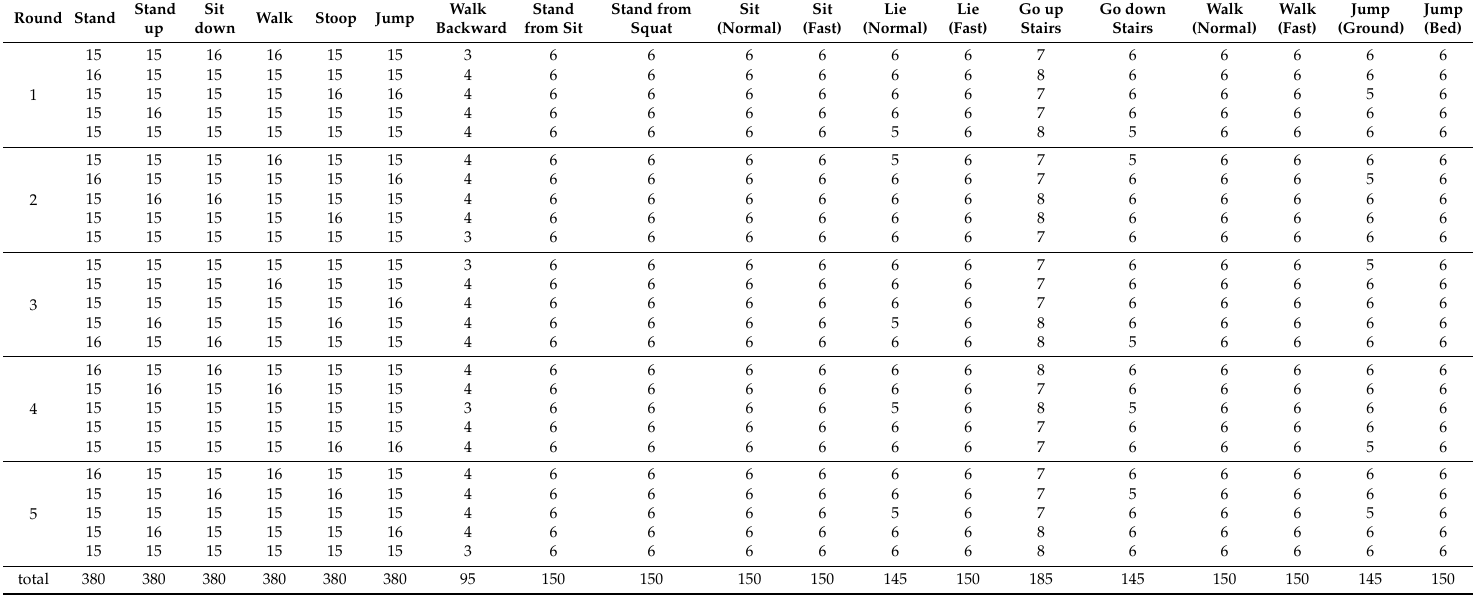
Table A1. The total testing data of falls and ADLs in each round of five-fold cross-validation